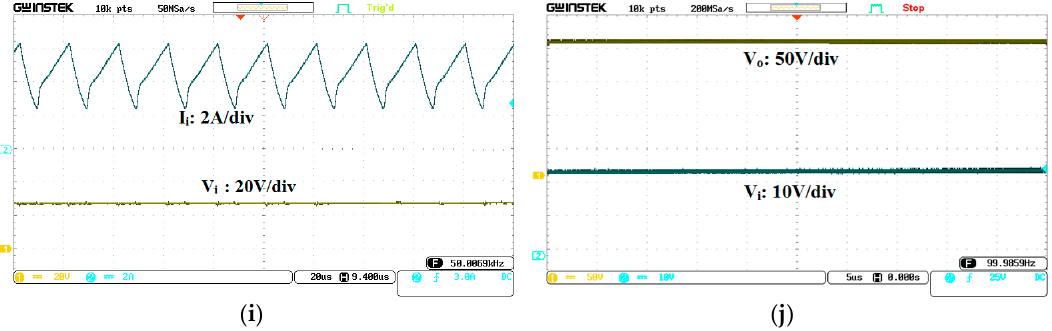
Figure 13. Various experimental waveforms of the proposed converter at full load. ( a ) V ds vs. V gs , ( b ) V ds vs. I ds , ( c ) V ds vs. V Dc , ( d ) I D1 vs. I Dc , ( e ) V D1 vs. V D2 , ( f ) V D2 vs. V D3 , ( g ) I D2 vs. I D3 , ( h ) V C vs. V Cox vs. V Coy , ( i ) V in vs. I in , ( j ) V in vs. V out .